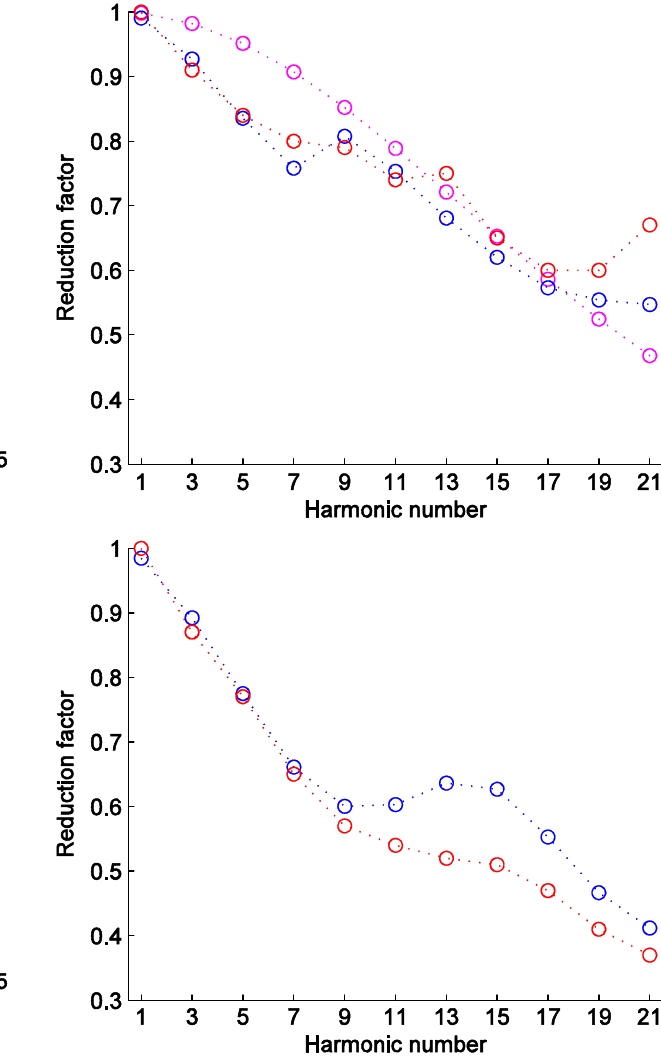
FIG. 19. Reduction factors in integrated flux (upper) and on- axis brightness (lower), calculated with UR [18] (red curves) and the dipole series model (blue curves), for the APS high phase error device. The magenta curve in the upper plot is the sim- plified estimate for the reduction factor in integrated flux based on the on-axis brightness spectrum. APS parameters are as in Fig.